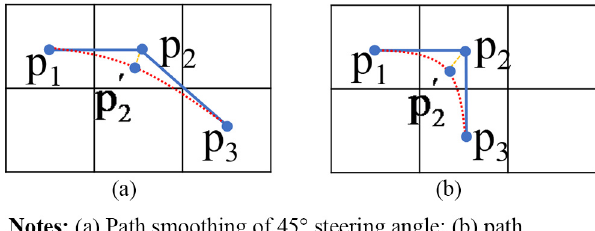
Figure 5 Path smoothing diagram